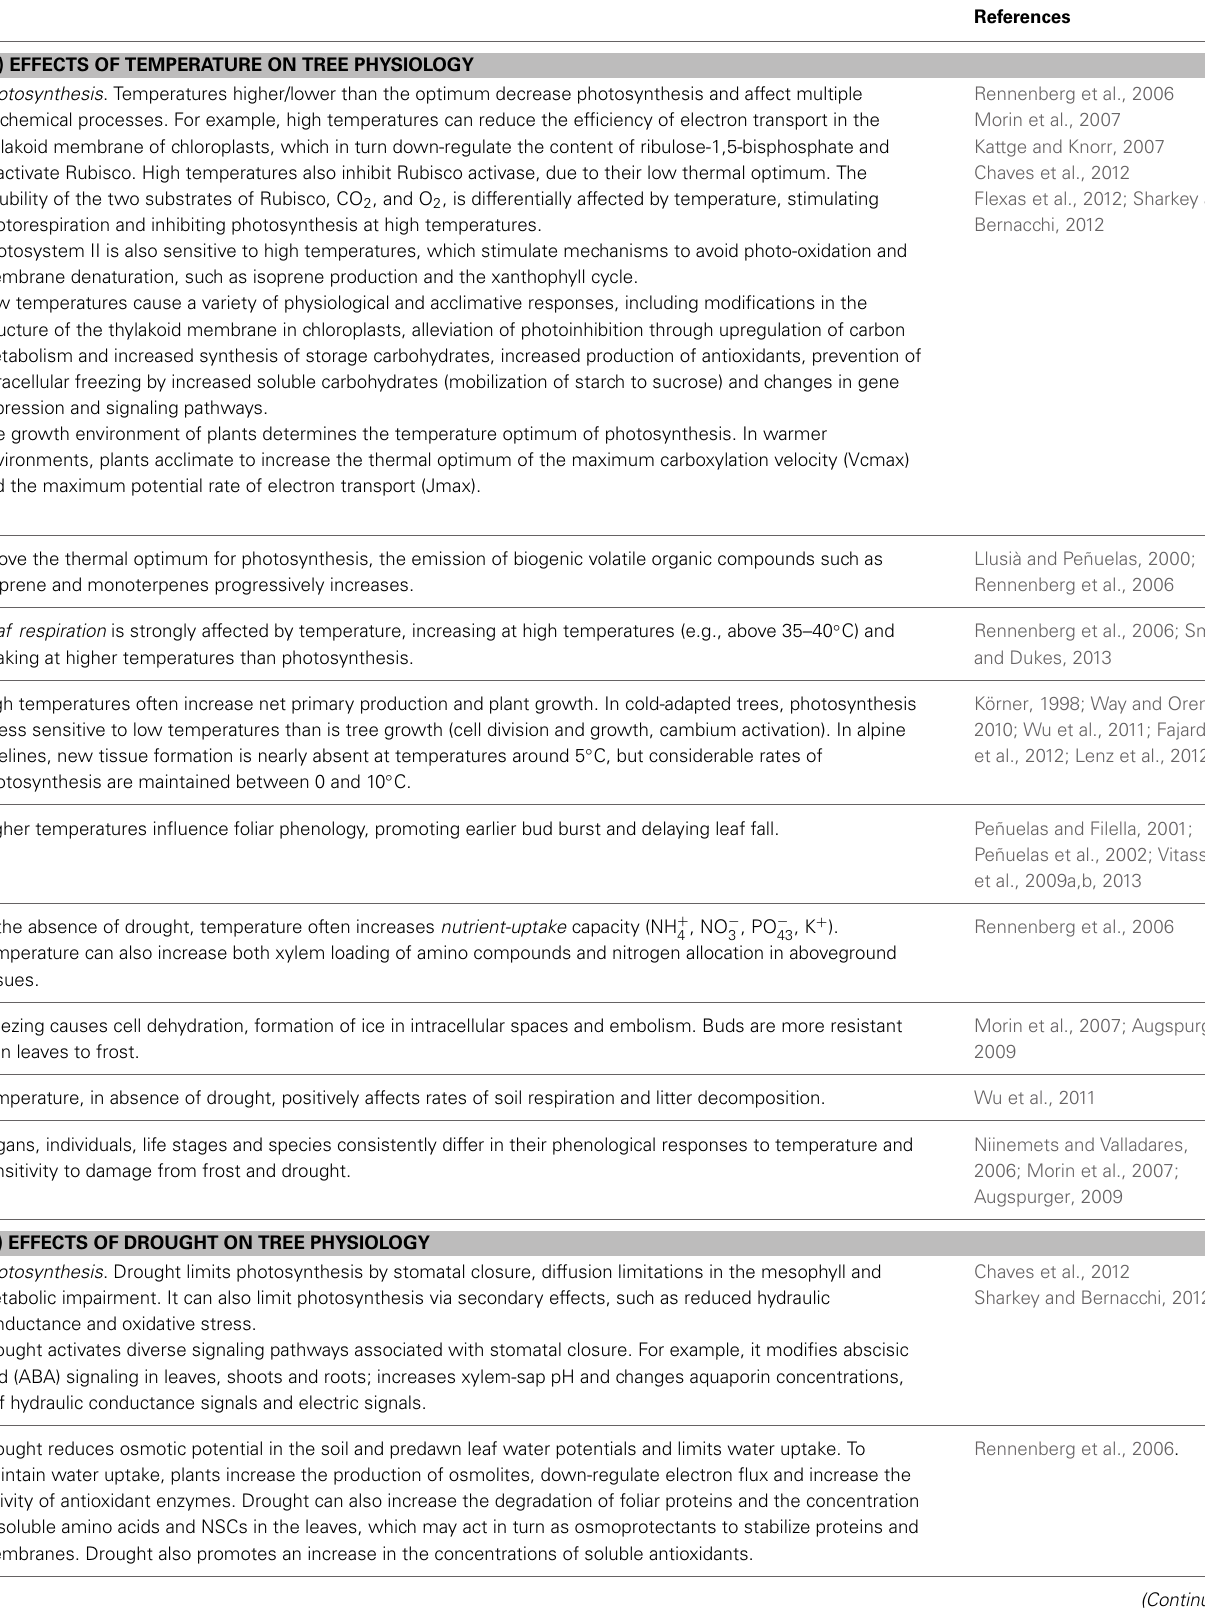
Table 4 | A non-exhaustive and synthetic review of the different effects of temperature (A) and drought (B) on different tree physiological